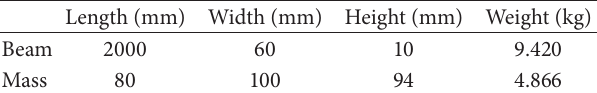
Table 1: Basic parameters of the